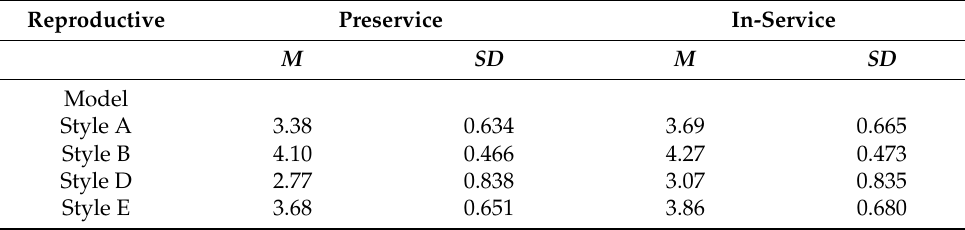
Table 5. Descriptive statistics for reproductive cluster (preservice and in-service